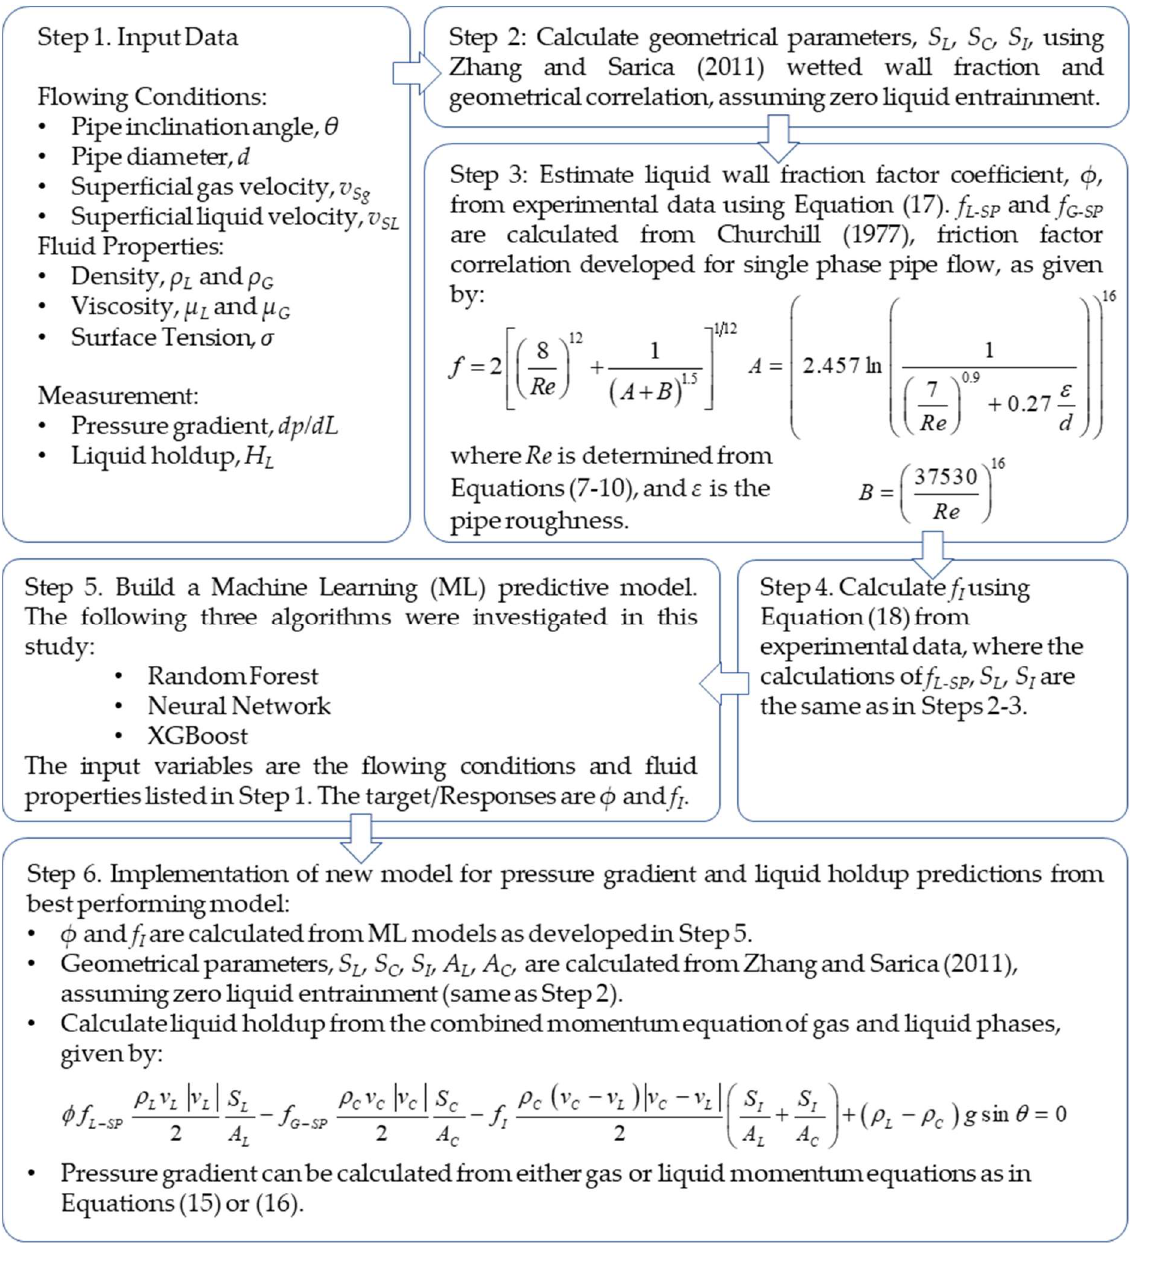
Figure 3. Workflow of model development (Steps 1–5) and model implementation (Step 5).